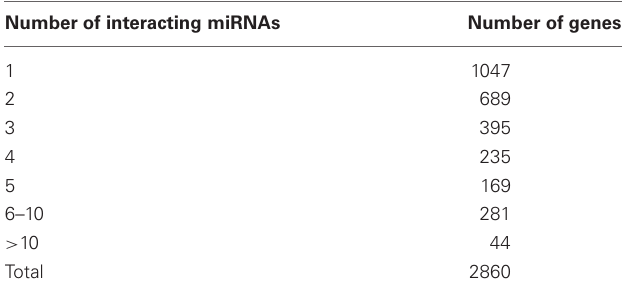
Table 1 | Distribution of CLIP-seq interactions with miRNAs of